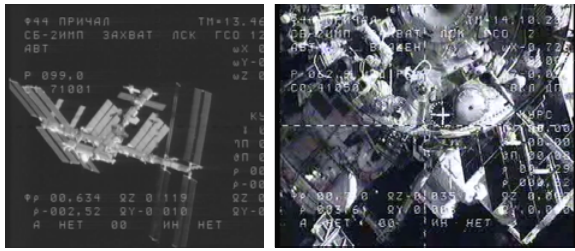
Figure 1. The ISS viewed from a distance of 600 m and 30 m Another important requirement that defines and restricts the choice of algorithms and the sequence in which various algorithms must be used is the real-time constraint. Measurement should also be highly accurate. In order to meet all these prerequisites, the contour-based algorithm was used. Its essential characteristics are investigated in this work. In order to increase the reliability of orientation parameters estimation and ensure pose tracking in real time, the statistical treatment of the resulting time series were also used; the ones allowing to obtain statistically validated